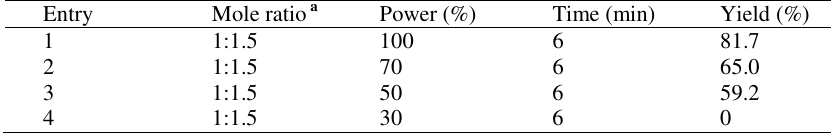
Table 2 Change the power of microwave irradiation